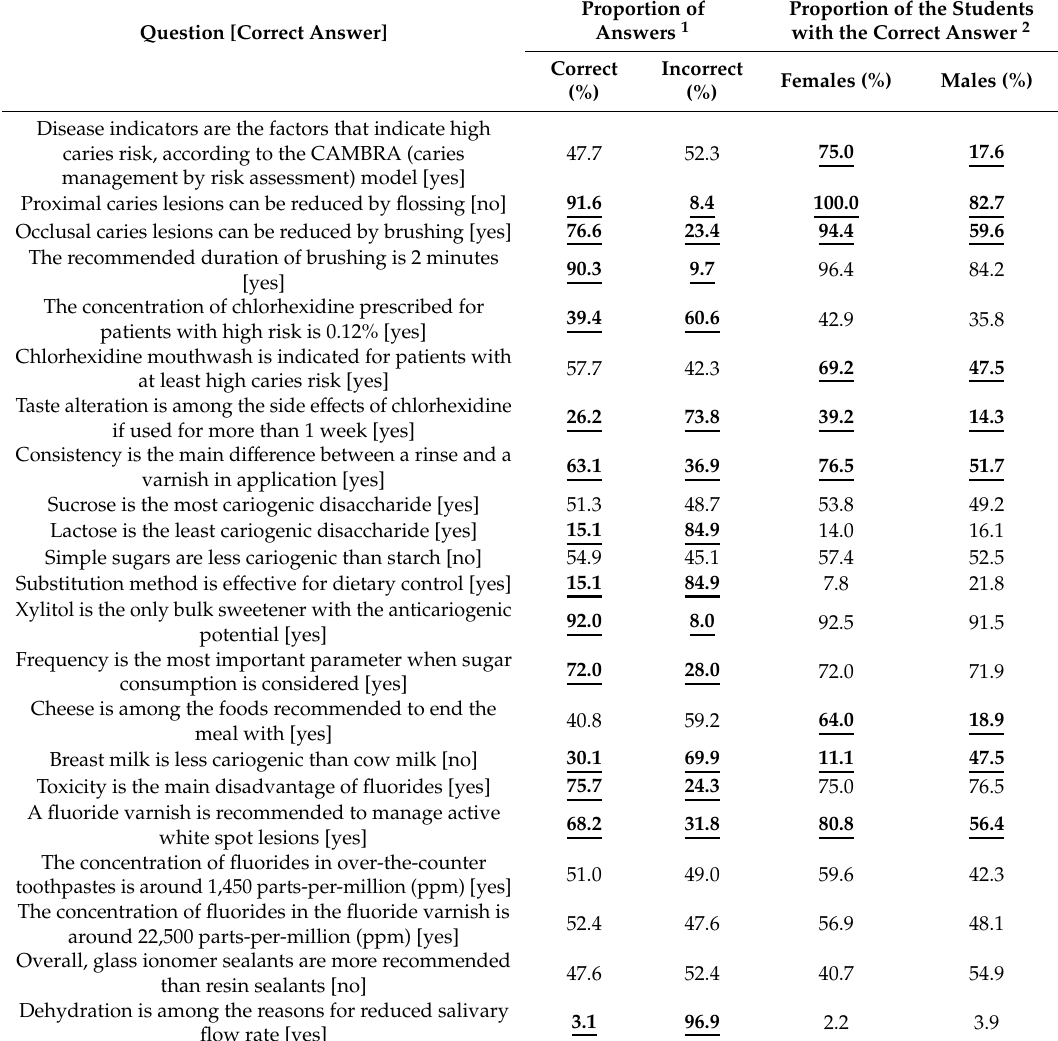
Table 1. The questions included in the survey with the correct answer in brackets (actual survey questions were not dichotomous), as well as statistical comparisons for each question of the survey showing proportions of correct vs. incorrect answers and proportions of female (n = 57) vs. male (n = 61) students with correct answers (total n =